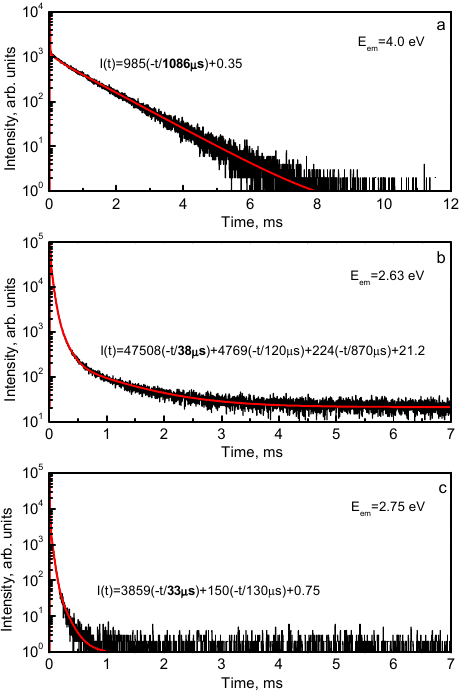
Figure 3. ( a ) Temperature dependences of the UV emission band maximum position in Y 3 Al 5 O 12 :Bi (solid line) and Lu 2 SiO 5 :Bi (dashed line), ( b ) the FWHM of the UV emission band in Lu 2 SiO 5 :Bi, and ( c ) the maximum intensities of the UV (4.0 eV, solid line) and VIS (2.5 eV, dashed line) emissions in Y 3 Al 5 O 12 :Bi reported in [17,18,21], presented with the publisher’s permission.